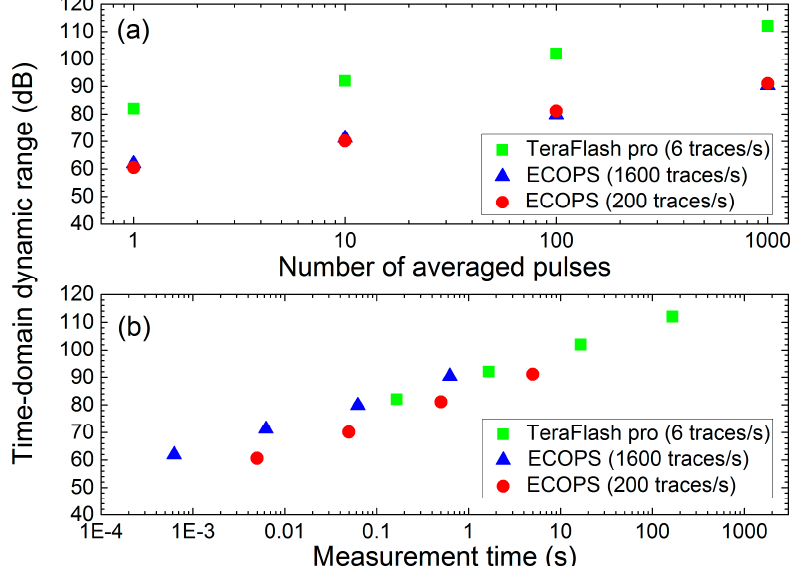
Figure 3. ( a ) TD-DR as a function of the number of pulse-trace averages. The plot compares values obtained with ECOPS at measurement speeds of 1600 traces per second (blue triangles), 200 traces per second (red circles) and a conventional terahertz TDS system (TeraFlash pro) operating at 6 traces per second (green squares). ( b ) Same data, as a function of the measurement time.